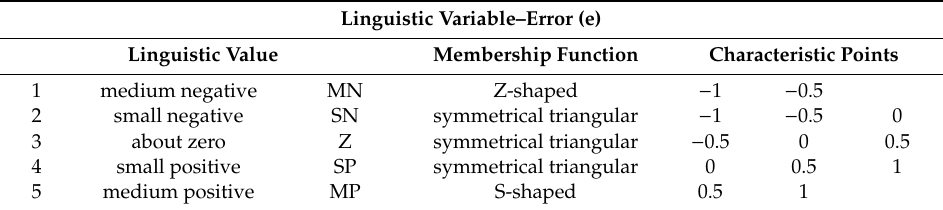
Table 11. The third version of the controller–error.